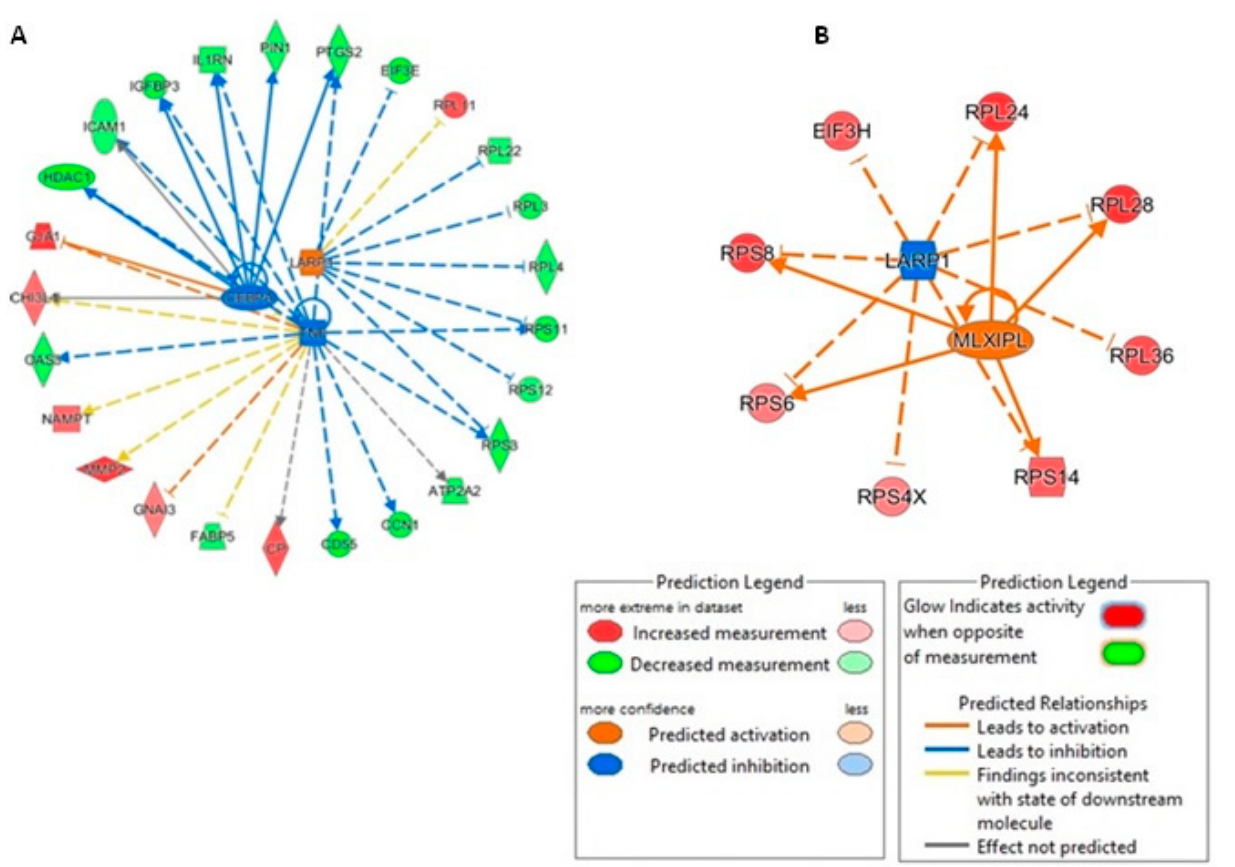
Figure 11. Network analysis of predicted upstream regulators of DE proteins in human OA chondro- cytes treated with miR-143-3p mimic, inhibitor or control. IPA analysis of DE proteins ( p < 0.05) in human OA chondrocytes treated with miR-143-3p ( A ) mimic or control and ( B ) inhibitor or control, identified a set of predicted upstream regulators in each comparison. Figure generated with IPA. Key is indicated.